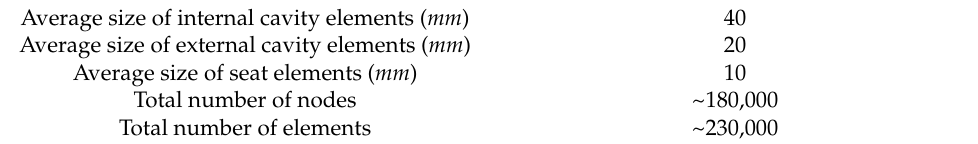
Table 2. Size of the acoustic cavity FEM elements and total number of nodes and elements. Average size of internal cavity elements ( mm ) 40 Average size of external cavity elements ( mm